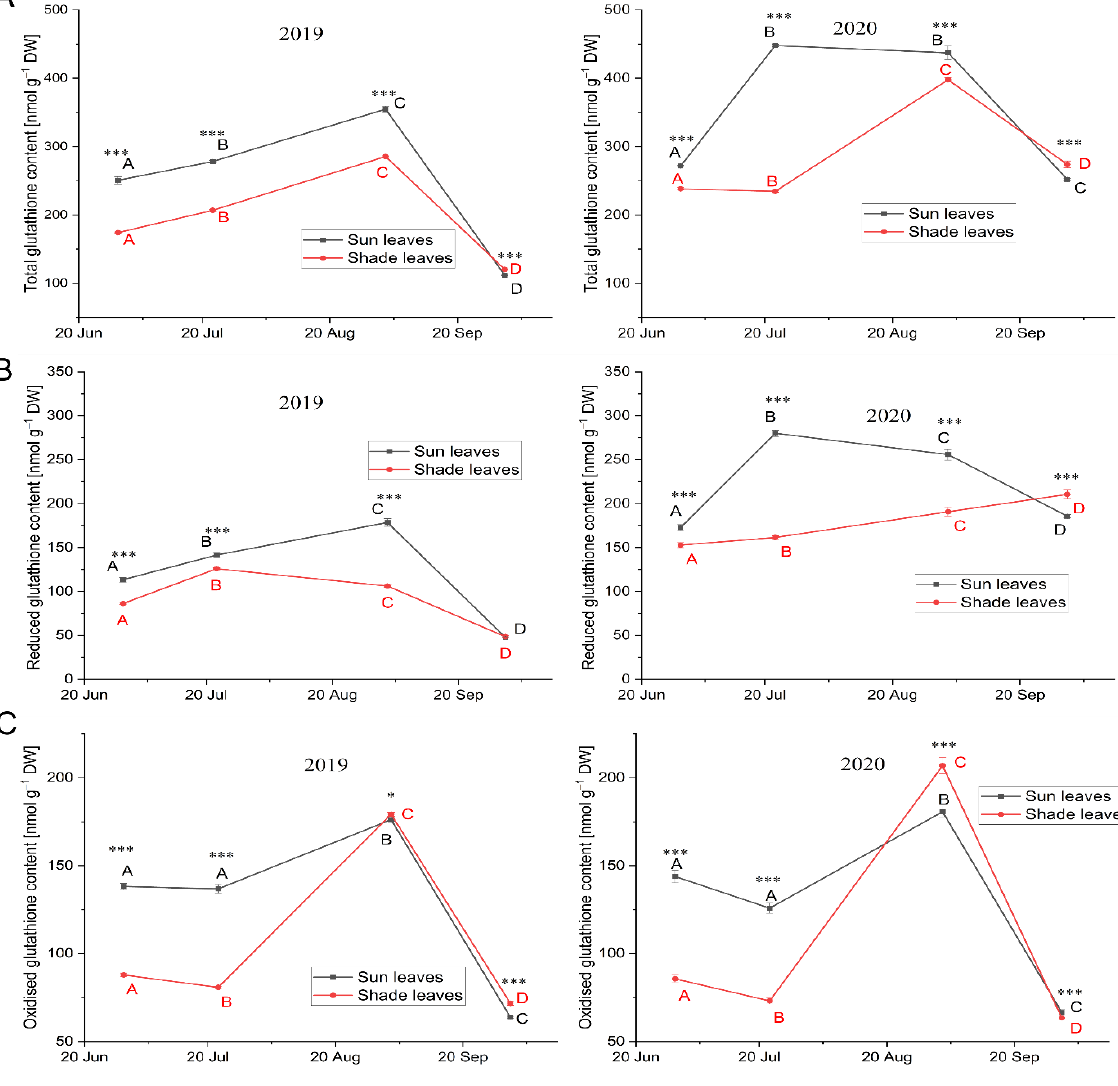
Figure 6. Changes in total glutathione ( A ), reduced glutathione ( B ), and oxidized glutathione ( C ) contents in the sun and shade senescing beech ( Fagus sylvatica L.) leaves. Analyses were performed for sun (black line) and shade (red line) leaves in 2019 and 2020. Each point is the mean of 60 measurements ( ± standard error). For each type of leaves, means with different uppercase letters differ significantly at p < 0.05. For each date, means with asterisks differ significantly at * — p < 0.05 and *** — p < 0.001.